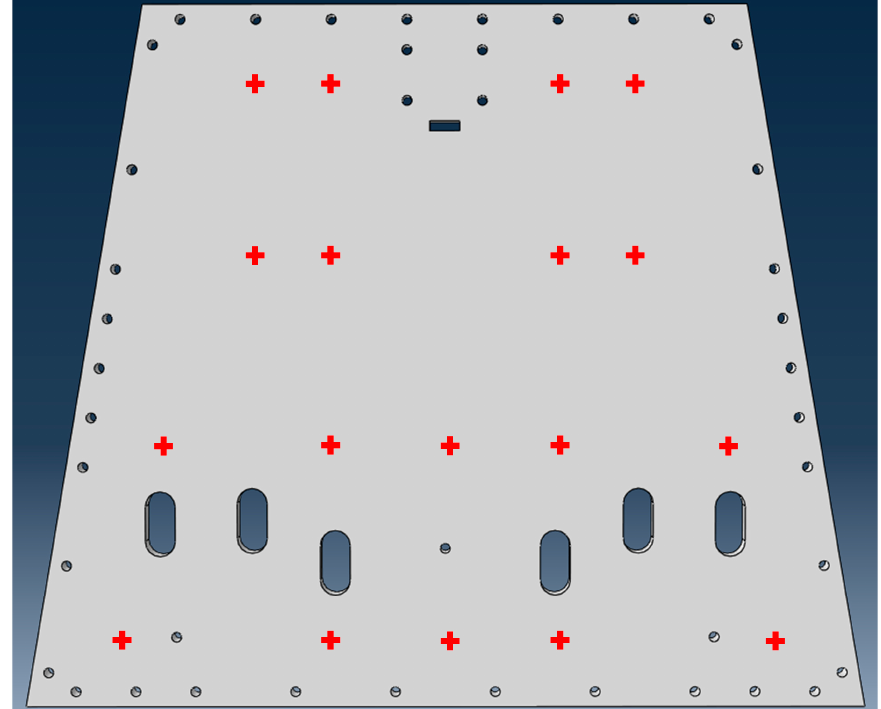
Figure 20. Schematic diagram of surface feature points.